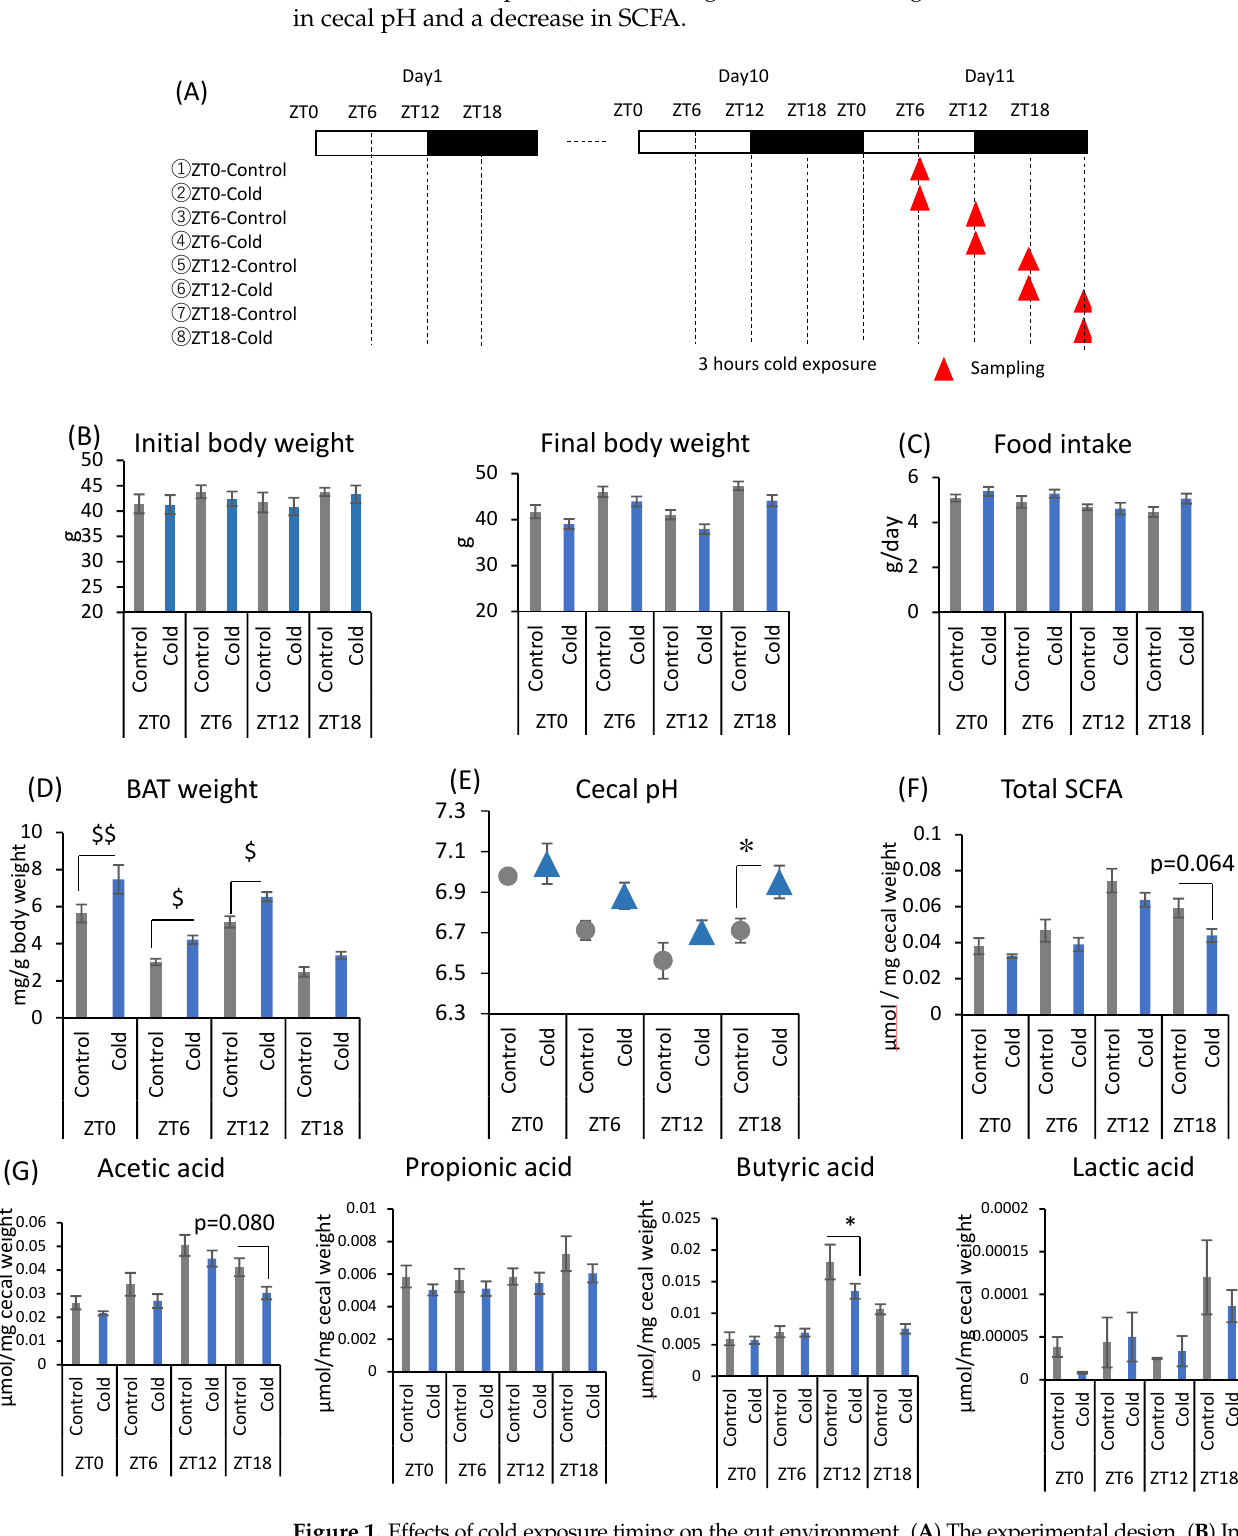
Figure 1. Effects of cold exposure timing on the gut environment. ( A ) The experimental design. ( B ) Initial body weight on day 1, final body weight on day 10. ( C ) Food intake per animal per day. ( D ) BAT weight corrected by body weight. ( E ) Cecal pH measured on day 11. ( F ) Total SCFA. ( G ) SCFAs (acetic acid, propionic acid, butyric acid, lactic acid) of mice were exposed to 22 or 7 °C for 3 h at each point (ZT0, 6, 12, 18) for 10 days. Data are represented as mean ± SEM ( n = 5–10). $ p < 0.05, $$ p < 0.01 evaluated using the Kruskal–Wallis test with a two-stage linear step-up procedure of the Benjamini, Krieger, and Yekutieli test for multiple comparisons. * p < 0.05 evaluated using two-way ANOVA with Sidak’s post hoc analysis. 2.2. Effects of Cold or Heat Exposure Timing on Gut Environment Mice were divided into six groups and exposed to a cold or heat environment at two different timings (ZT6 or ZT18) to determine whether this alteration of the gut environ- ment is specific to cold exposure (Figure 2A). There were no significant differences in in- itial body weight and final body weight between cold and control groups at both ZT6 and ZT18 (Figure 2B). Heat exposure at ZT6 significantly decreased food intake compared to cold group (Figure 2C). Cold exposure increased BAT weight corrected by body weight at ZT6. However, there was no significant difference in BAT weight caused by cold or heat exposure at ZT18 (Figure 2D). Body temperature significantly decreased during cold exposure compared with that in control group at both ZT6 and ZT18 (Figure 2E). The body temperature of mice exposed to cold temperature gradually decreased from the beginning of the exposure and showed the lowest body temperature (ZT6-cold: 35.64 ± 0.16 °C, ZT18-cold: 36.00 ± 0.19 °C) at the end of the exposure period. Compared with the control group, the ZT6-cold group showed a significant decrease in body temperature at ZT6 and ZT7, and ZT18-cold group showed a significant decrease in body temperature at ZT18 and ZT19, respectively. After the exposure period, the body temperature recovered rapidly to the same level as the control group in the ZT18-cold group, and reached a higher temperature than the control group in the ZT6-cold group. Comparison of the difference of body temperature between the cold group and control group revealed a decrease of 0.49 and 1.05 °C for the ZT6 and ZT18 groups, respectively. Since the body temperature of mice has a circadian rhythm that is high during the active phase and low during the inactive phase, a greater decrease in body temperature under cold environ- ment was observed in the ZT18 group, which had a higher body temperature in the con- trol group. On the other hand, body temperature was slightly affected by heat exposure (Figure 2E). At ZT6, body temperature exposed to heat environment increased at the be- ginning of the exposure and then was maintained at the same level as the control group; however, it decreased after the exposure. At ZT18, body temperature decreased slightly during the exposure period and further decreased after the exposure.